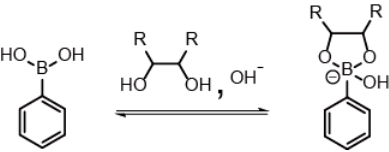
Figure 6. Binding equilibrium of PBA and diol compound.